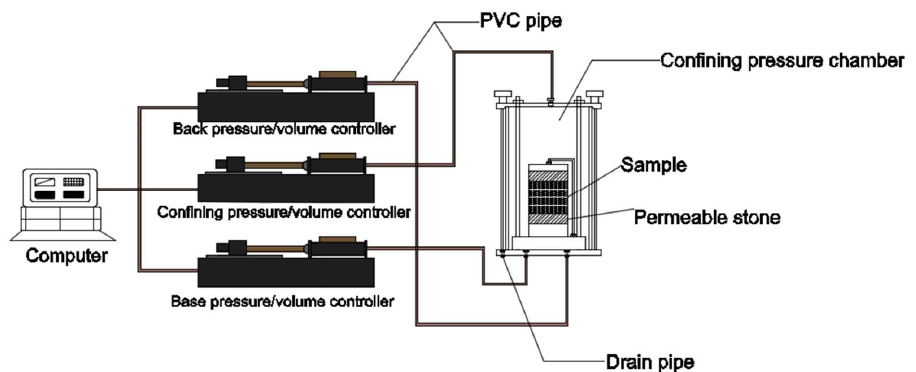
Figure 1. GDS flexible-wall penetrometer.